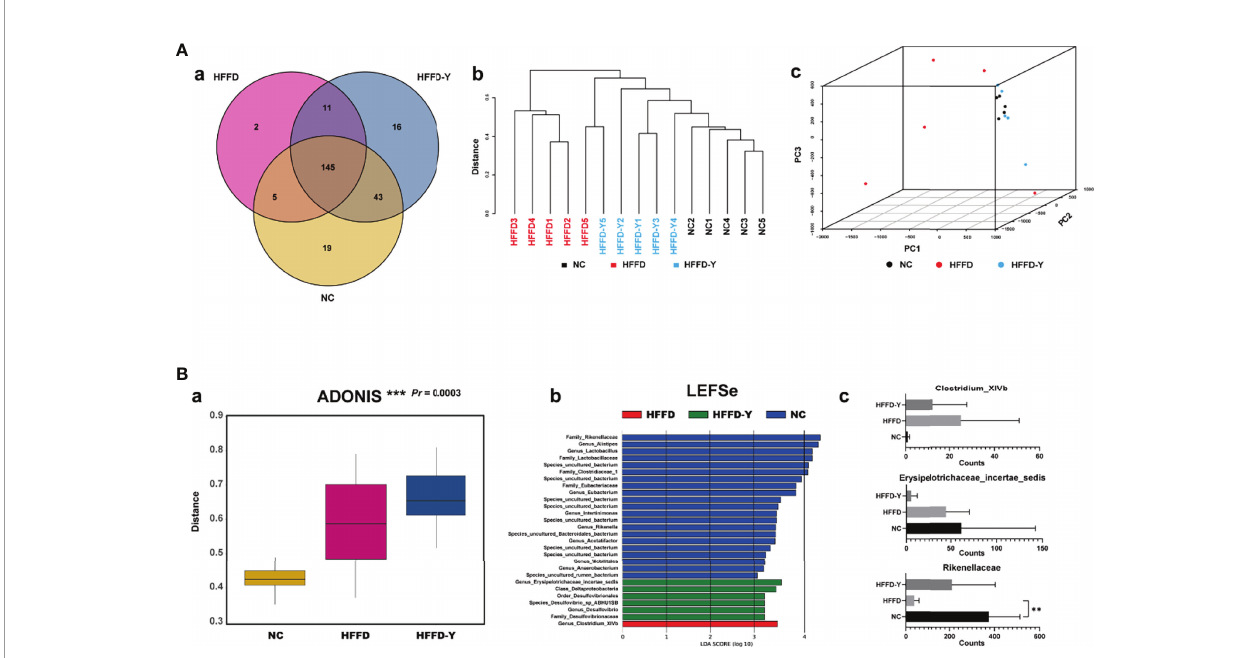
FIGURE 6 | Results of Beta Diversity analysis. (A) Results re fl ect the similarities and differences of the gut microbiome in the mouse. (B) Results show the signi fi cant difference between the NC, HFFD, HFFD-Y groups, and the gut microbiota, causing the above difference. (** p <0.01 vs